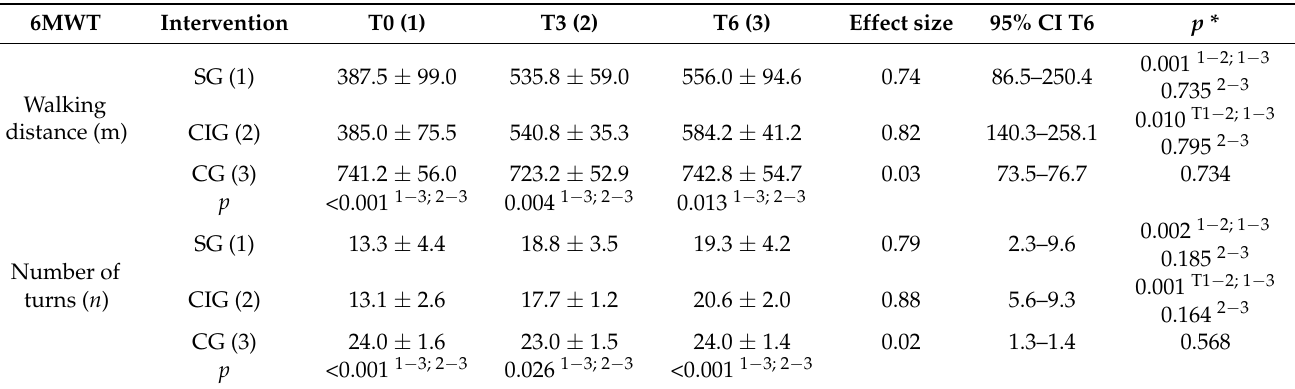
Table 4. Six-minute walk test (6MWT) in the inter-group comparisons: minimalist shoe (SG), custom insole (CIG), and control group (CG), and interventions: T0 (baseline) and after T3 and T6 months of intervention in women with plantar fasciitis